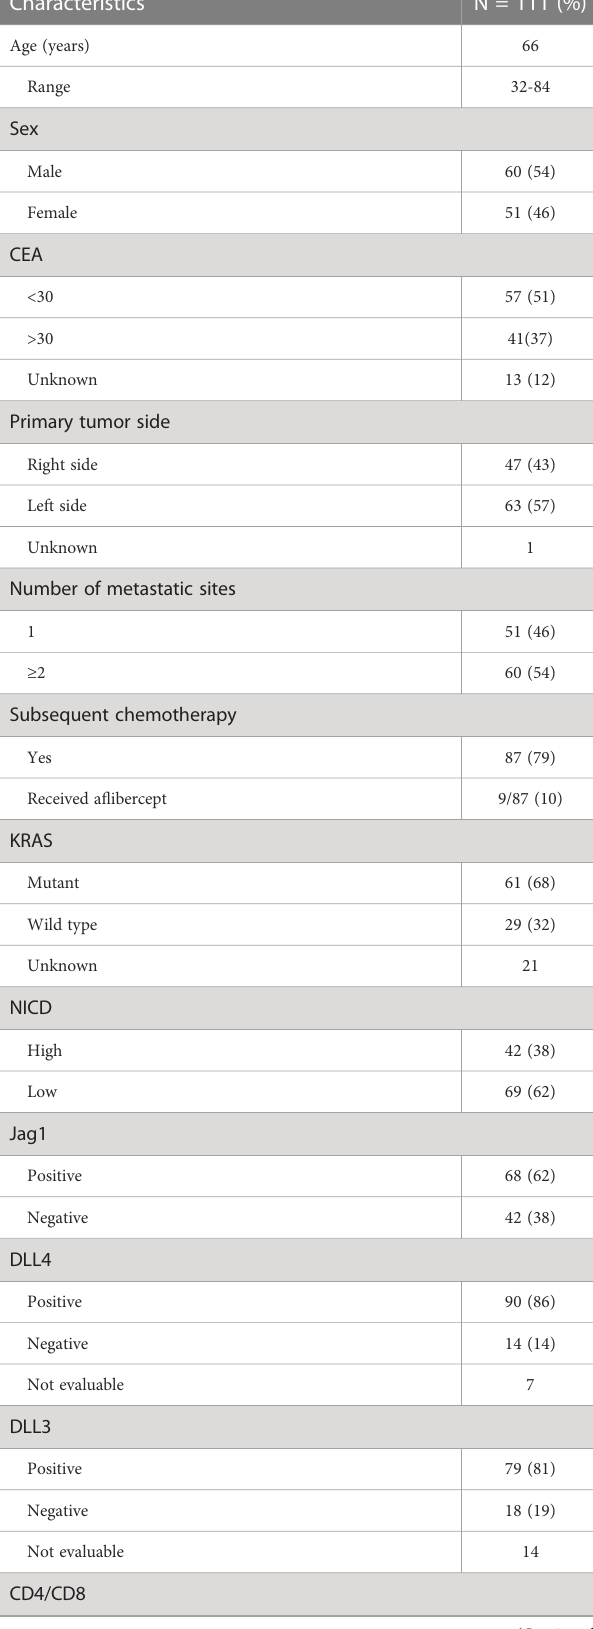
TABLE 1 Patients ’ characteristics and tissue microarray expression data.